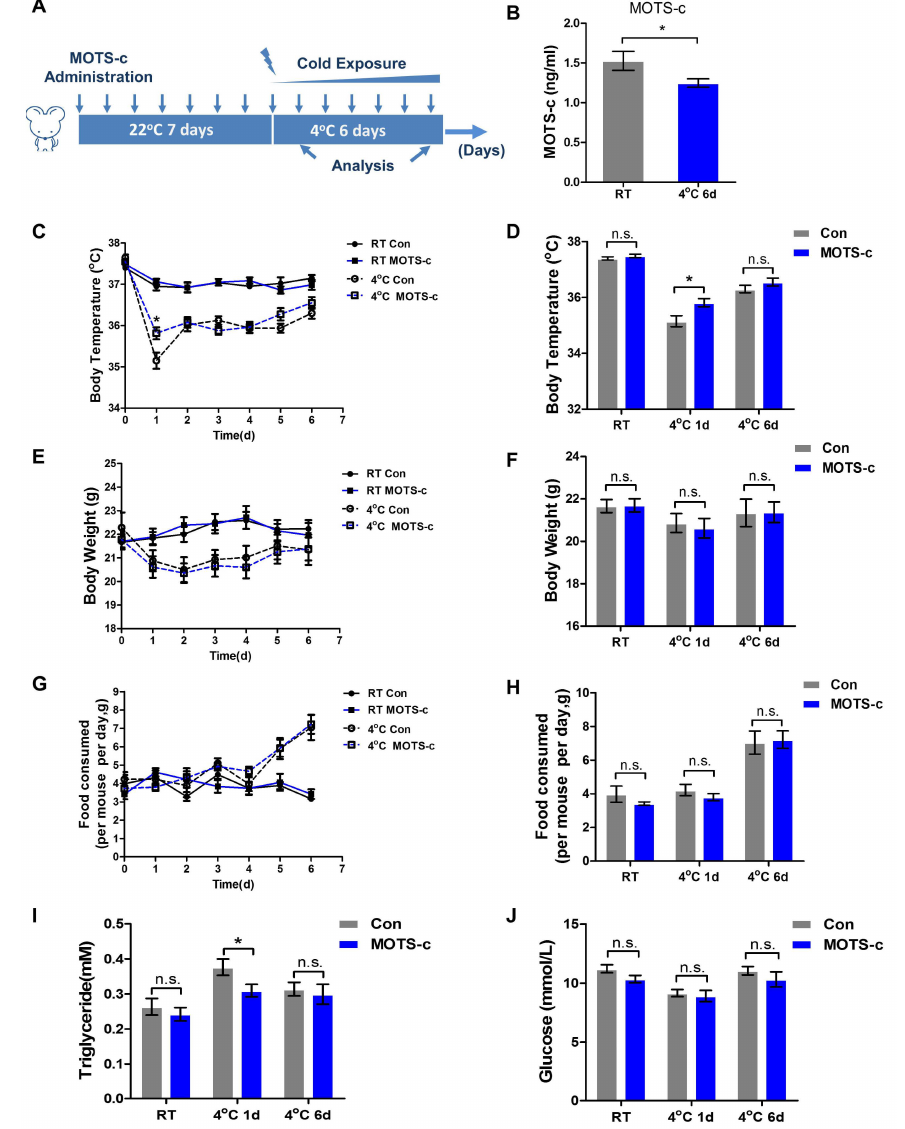
Figure 1. MOTS-c administration increases the ability of cold adaptation upon acute cold exposure. ( A ) Experimental design for the study in MOTS-c administration upon cold exposure. ( B ) The serum level of MOTS-c following 4 ◦ C exposure and the standard curve and 450 nm absorption signaling are shown ( n = 8 per group). ( C , D ) Body temperature during cold exposure and the change in body temperature was analyzed at the first and sixth days of cold exposure. ( n = 8 per group). ( E , F ) Body weight during cold exposure and the change in body weight was analyzed at the first and sixth days of cold exposure ( n = 8 per group). ( G , H ) Food intake during cold exposure and the change in food intake was analyzed at the first and sixth days of cold exposure. ( n = 8 per group). ( I , J ) The serum levels of triglycerides and glucose were detected at the first and sixth days of cold exposure. ( n = 8 per group). All data are represented as mean ± SEM. Di ff erences between the two groups were determined by a two-tailed Student’s t -test. * p < 0.05, n.s. = not